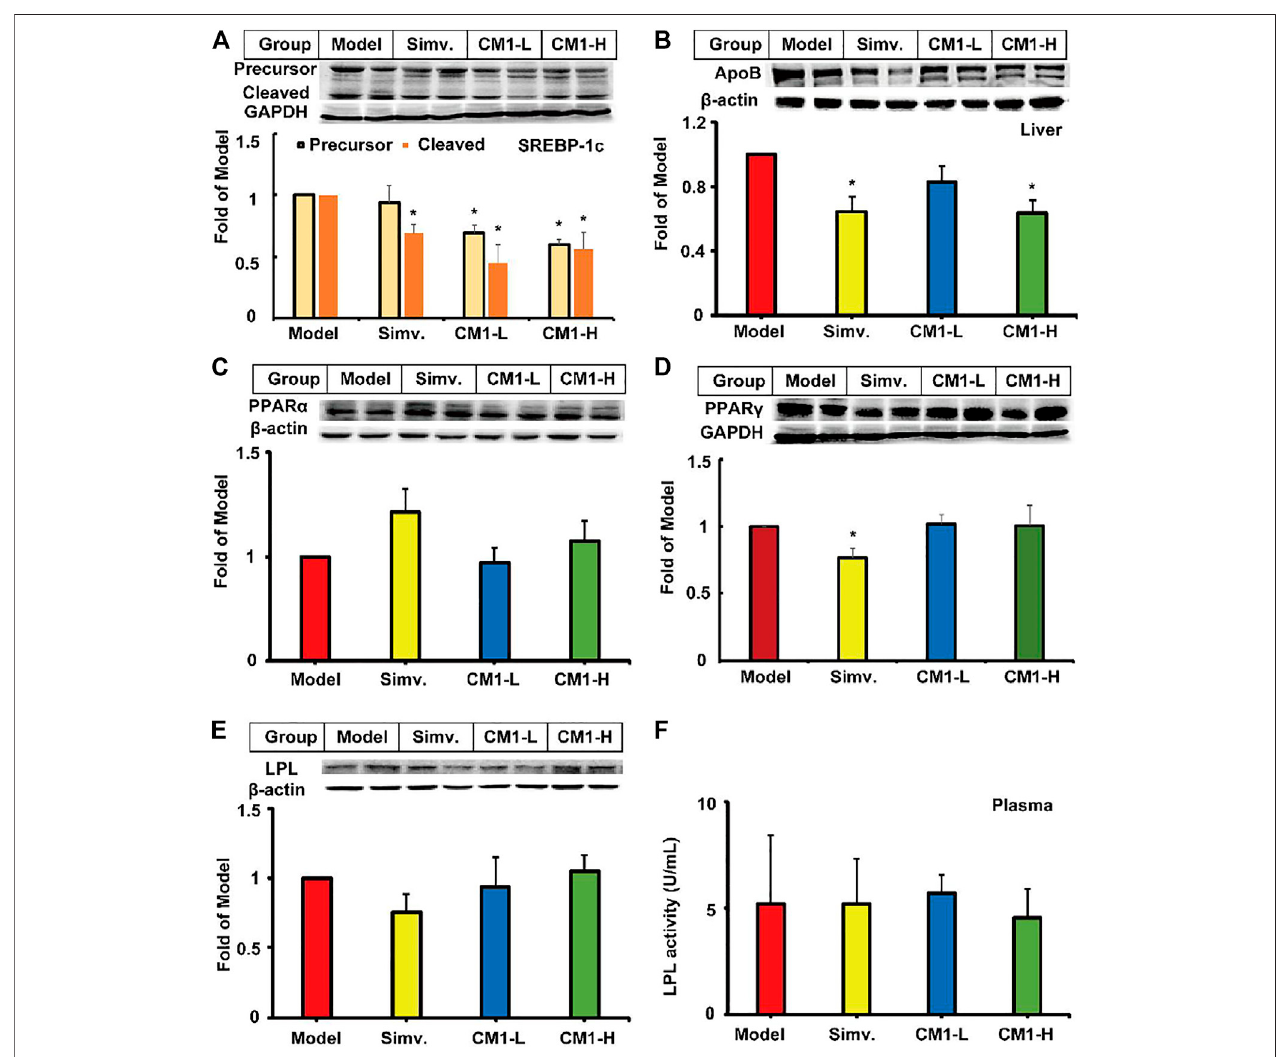
FIGURE 4 | Effect of CM1 on TG metabolism related proteins in the liver and plasma of the LDLR (-/-) mice ( n ≥ 4). Protein expression and densitometric quanti fi cation. (A) , SREBP-1c, precursor ( ∼ 125 kDa) and cleaved mature form ( ∼ 68 kDa); (B) , apoB; (C) , PPAR α ; (D) , PPAR γ ; (E) , LPL; (F) , LPL activity in the plasma. *means p < 0.05 vs .